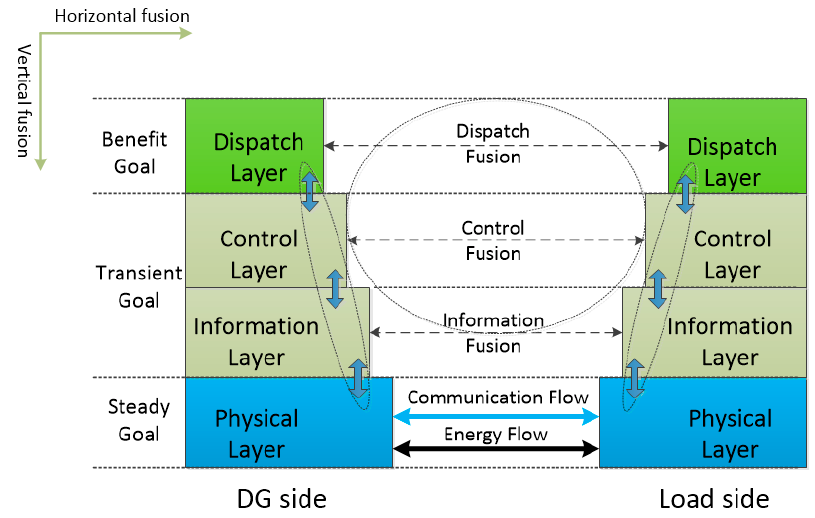
Figure 3. Two-dimensional fusion for microgrid with composite loads.